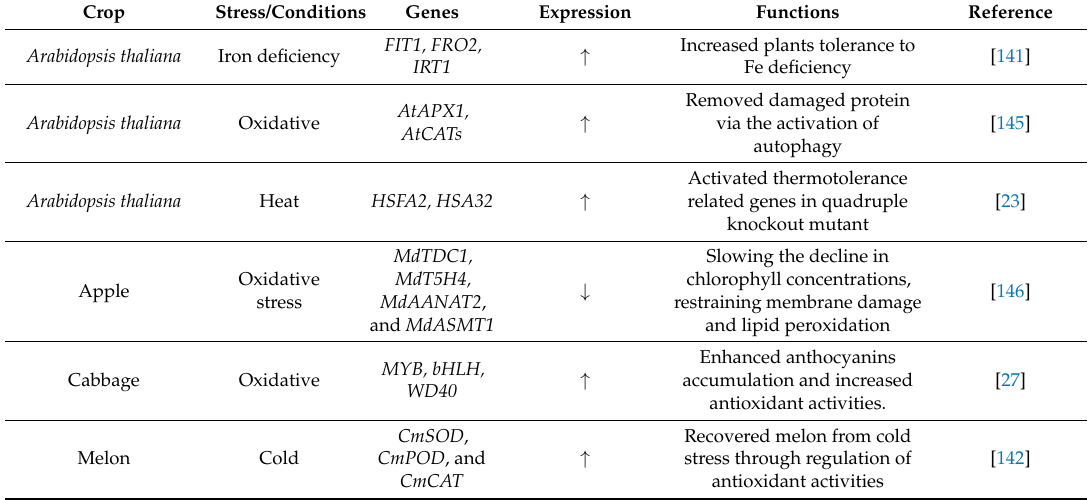
Table 5. Role of exogenous melatonin in regulating gene